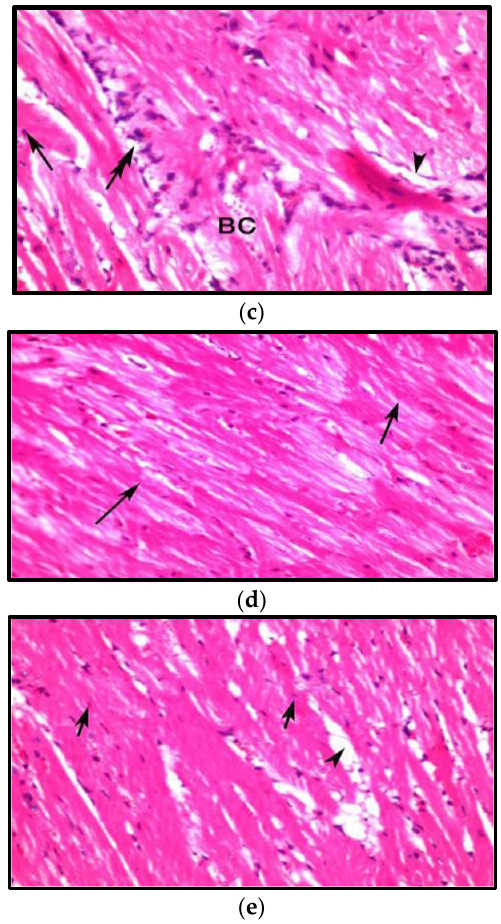
Figure 6. Histology of heart section stained with hematoxylin and eosin (original magnification ×200) from each group: G5: high-cholesterol diet (Ch); G6: Ch + Lp + Lc; G7: Ch + Sp; G8: Ch + Lp + Sp; G9: Ch + rosuvastatin. ( a ) G5: Section in cardiac tissue showing dilated congested blood vessels, many cardiomyocytes with deeply stained cytoplasm, and pyknotic nuclei (arrow head) atropheid cardiomycetes (H&E. 400×). ( b ) G6: Section in cardiac tissue showing intact cardiomyocytes and few interstitial hemorrhagic areas with pyknotic nuclei (arrowhead) (H&E. 400×). ( c ) G7, Section in cardiac tissue showing pyknotic nuclei and deeply stained cytoplasm (arrow), inflammatory cells infiltrate (double arrow), dilated blood capillaries (BC), edema (arrowhead) (H&E. 400×). ( d ) G8: Section in cardiac tissue showing intact cardiomyocytes (arrow) (H&E. 400×). ( e ) G9: Section in cardiac tissue showing intact cardiomyocytes (arrow) with vesicular nucleus, mild edema in interstitial spaces (arrowhead) (H&E. 400 ×